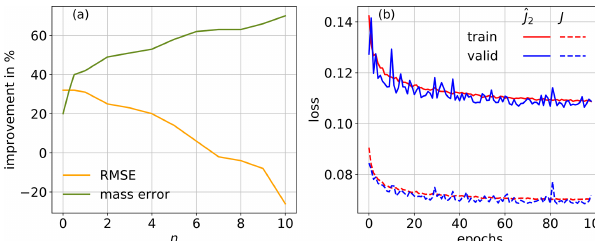
Figure 5. (a) Relative improvement in the percent of RMSE (or- ange) and mass error (green) towards the output with respect to the input as a function η . (b) Value of the loss function ˆ J (solid) and J (dashed) averaged over samples for the training (red) and validation (blue) data set as function of epochs for dT10 η = 2